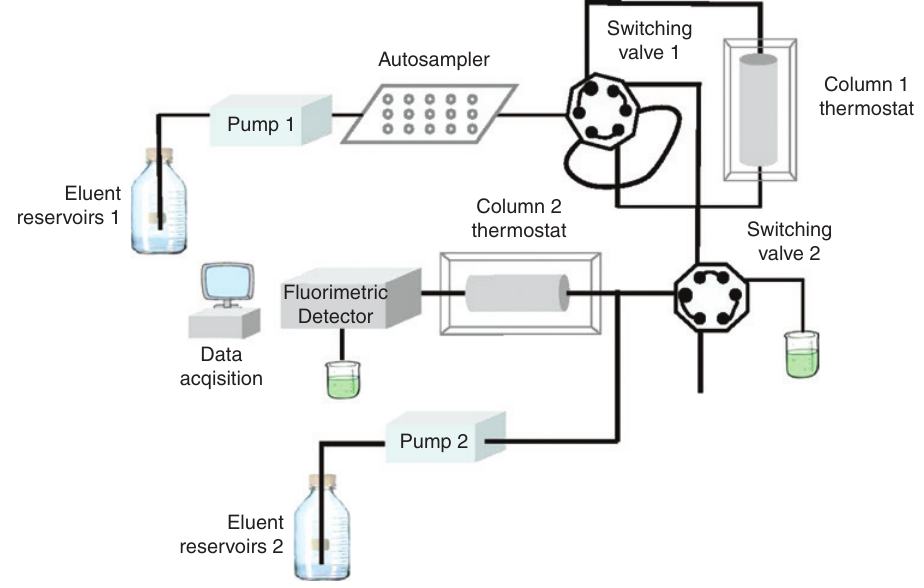
Figure 4: Schematic diagram of a semiautomated two-dimensional HPLC system to analyze NEO in serum. Adapted from